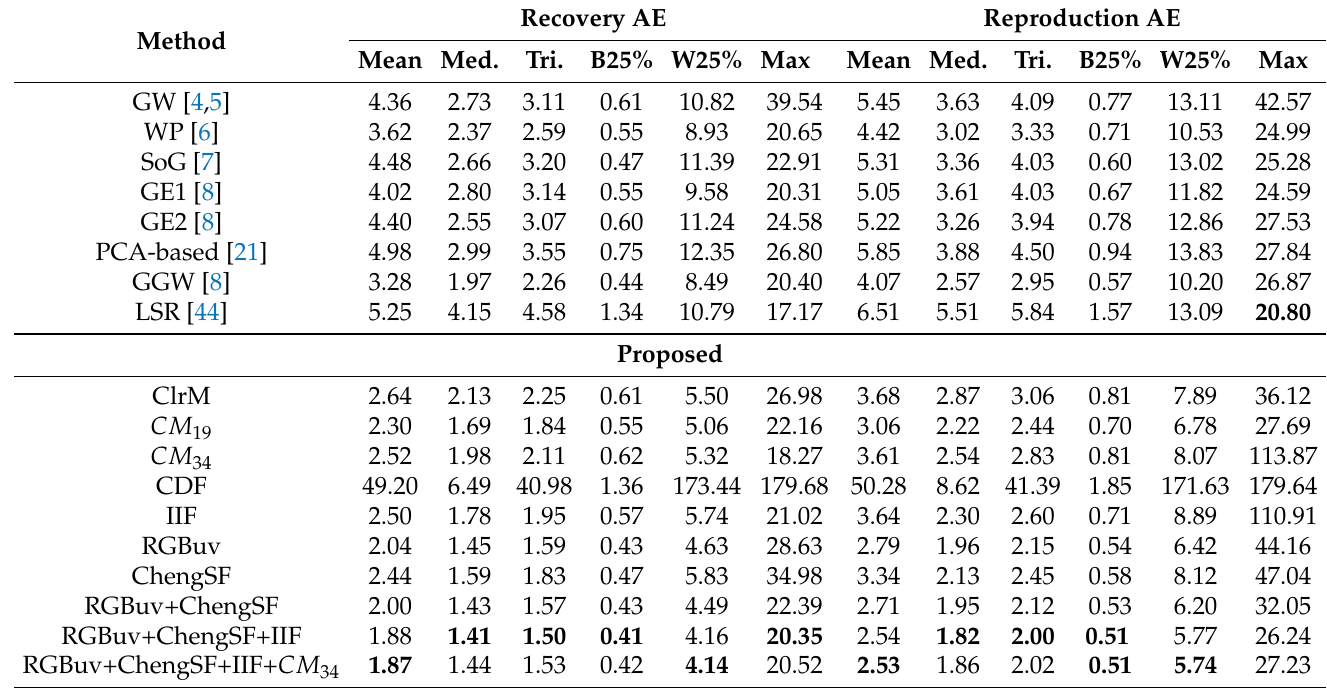
Table 4. Comparative performance metrics between the proposed method and some conventional methods for Canon EOS